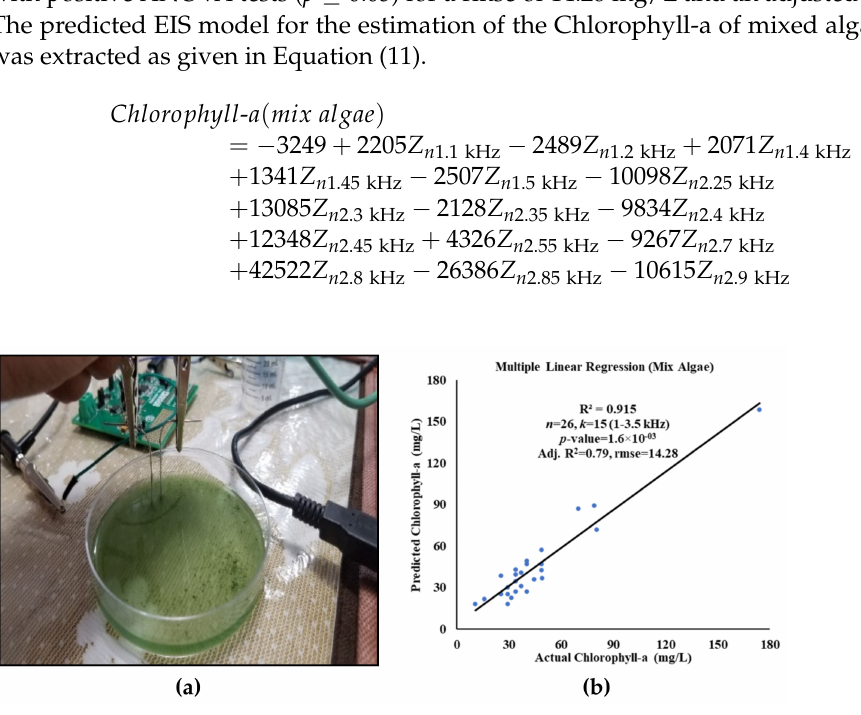
Figure 7. EIS measurements and performance analysis of mixed algae considering multiple regres- sion: ( a ) measurement by the electrodes, and ( b ) multiple regression at 1–3.5 kHz. The overall correlation obtained was 96% for 26 samples of mixed algae